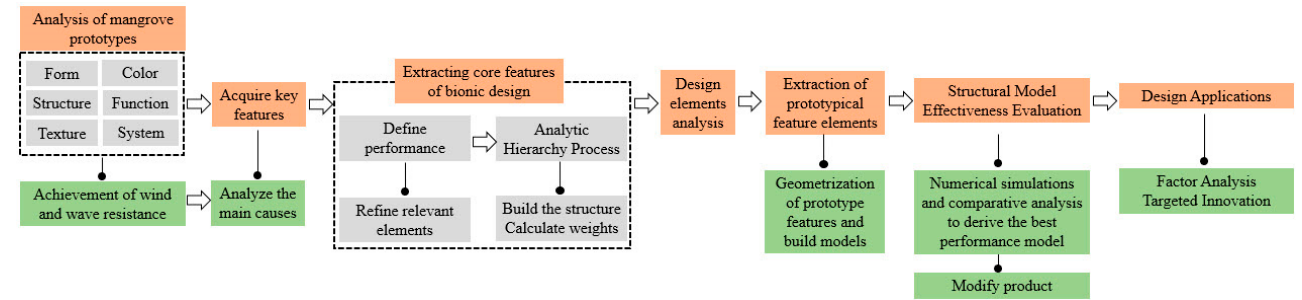
Figure 9. The design flow chart of disaster prevention and mitigation structure products based on mangrove bionics.